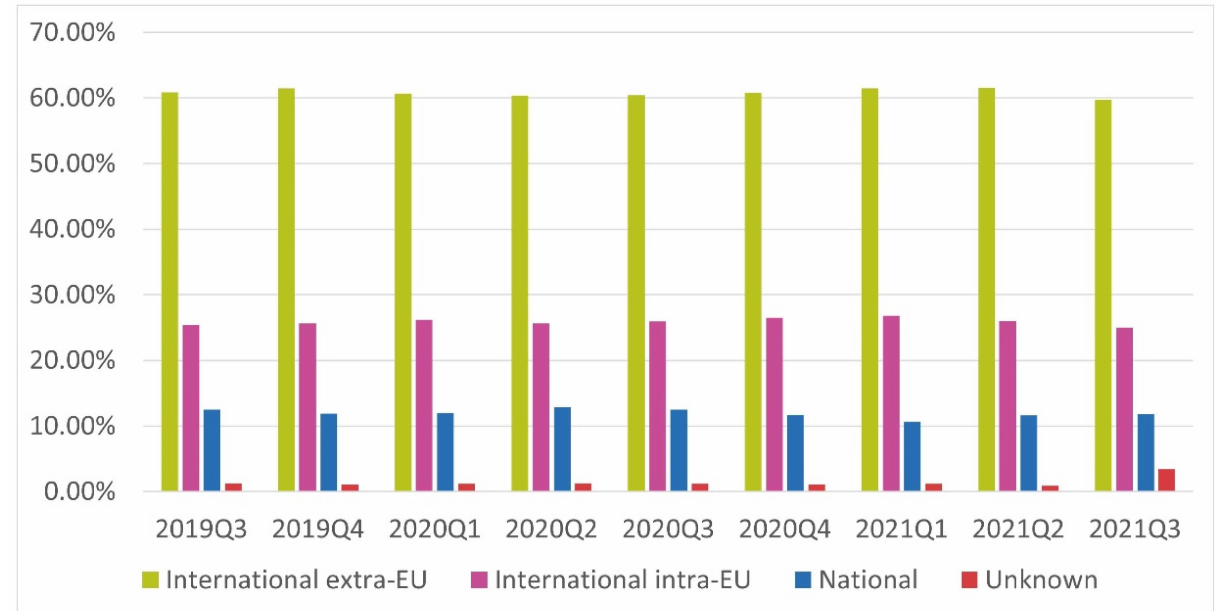
Figure 2. Percentage of imports/exports handled by EU ports as extra-EU, intra-EU, and national by type of transport per quarter, EU, 2019Q3–2021Q3. Data processed from Eurostat